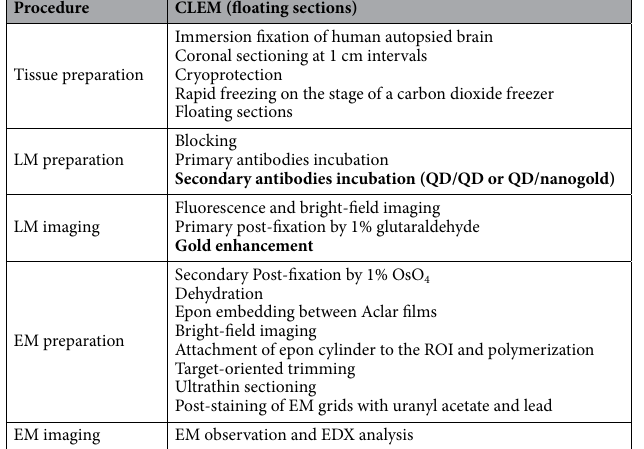
Table 1. A summary of QD-CLEM protocols for floating